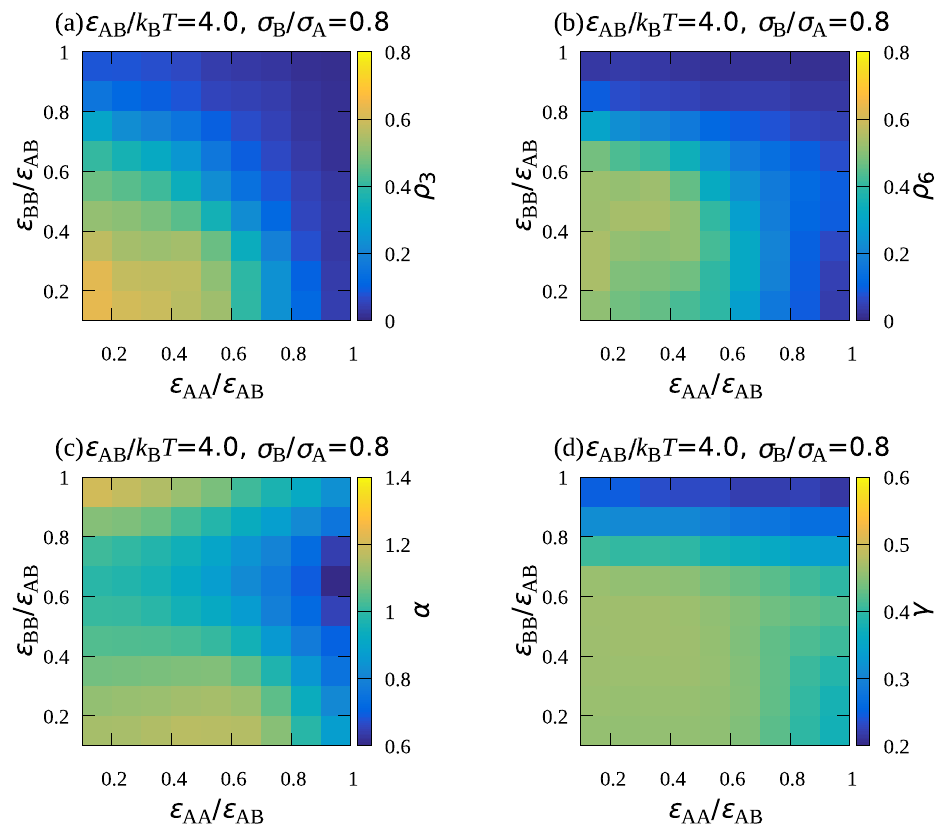
Figure 3. Dependence of ( a ) ρ 3 , ( b ) ρ 6 , ( c ) α , and ( d ) γ on ε AA /ε AB and ε BB /ε AB , where ε AB / k B T = 4.0 , σ B /σ A = 0.8 , and ρ = 0.1 . ρ 3 and ρ 6 represent the ratios of highly ordered B particle and A particle to all the particles attached to the bottom wall, respectively, α shows how the composition ratio of A particles on the bottom wall is higher than that in the system, and γ shows the ratio of the number of particles attaching to the wall to that of all the particles in the